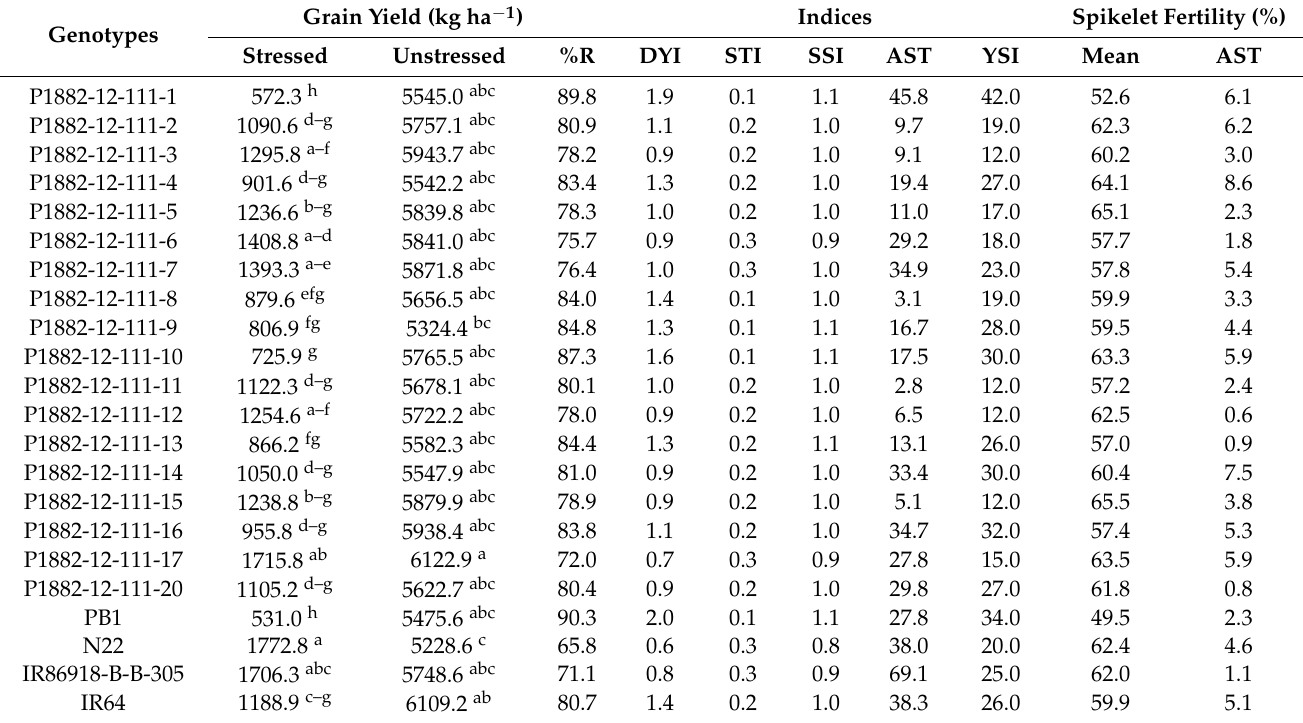
Table 5. Drought tolerance and stability indices for grain yield among the NILs and checks averaged across seasons, with stability for spikelet fertility under